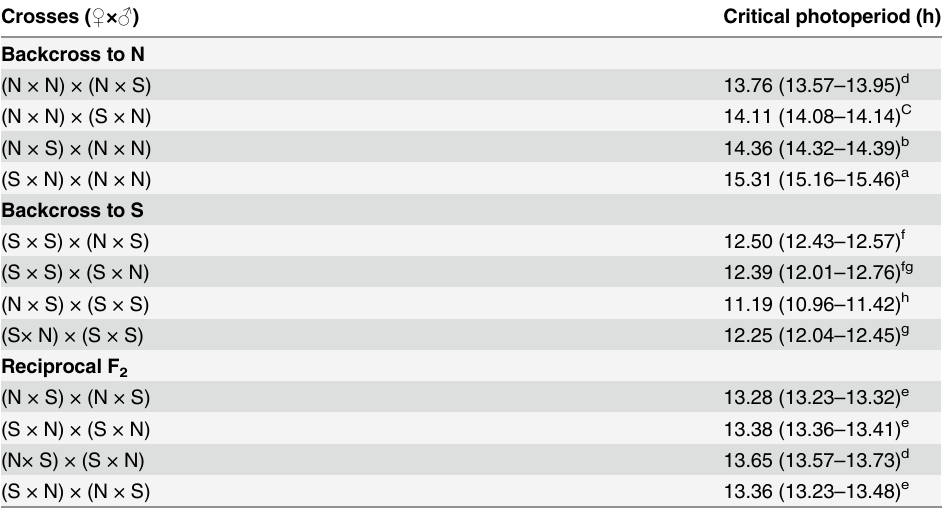
Data are means and 95% con fi dence intervals, values followed by the same superscript lowercase letter do not differ signi fi cantly at the 5% level by Tukey ’ s test after one-way analysis of variance. N, the northernmost Harbin strain; S, the southernmost Ledong